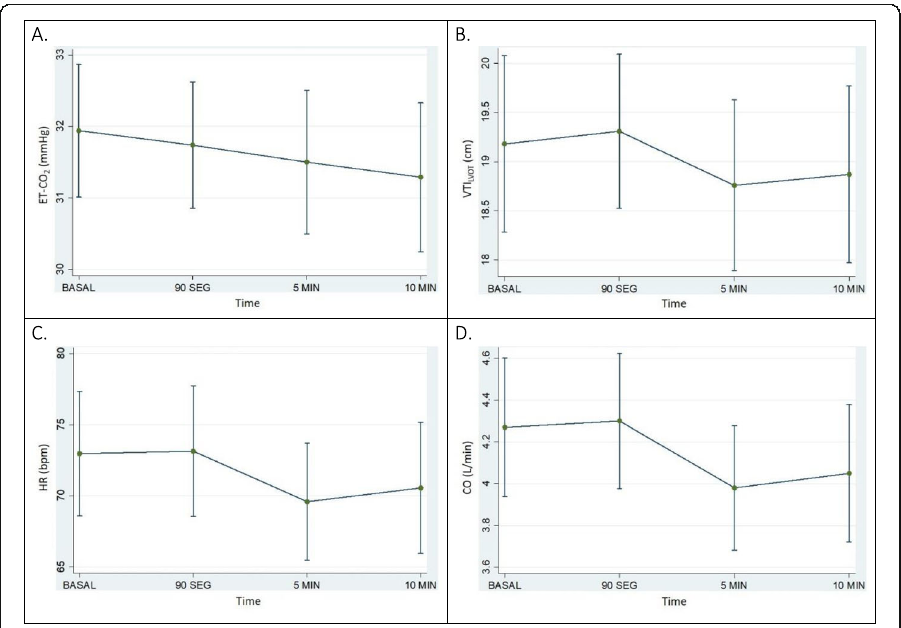
Fig. 3 Among non-responders, behavior during PLR maneuver of a ET-CO2, b VTI LVOT , c HR, and d CO. ET-CO2, end-tidal carbon dioxide; VTI LVOT , left ventricle outflow tract velocity time integral; HR, heat rate; CO, cardiac